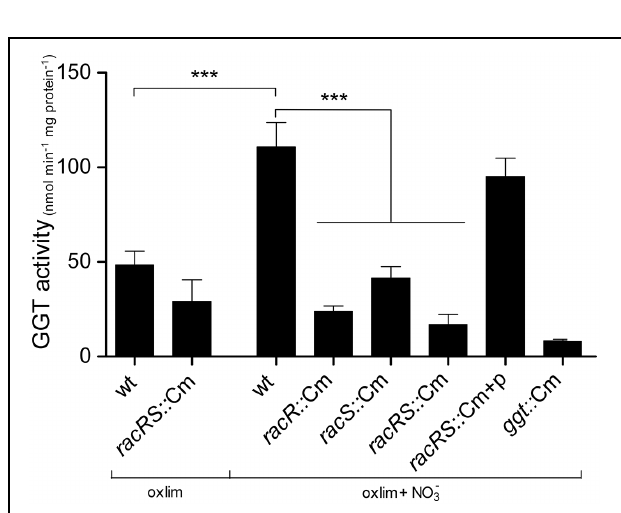
FIGURE 1 | RacR activates ggt transcription. Real-time RT-PCR data showing the transcript fold difference of the aspA, gltB, and ggt mRNA in the Campylobacter jejuni racR mutant ( racR ::Cm) and complemented strain ( racR ::Cm + p) compared to the wt. Cultures were grown in Heart Infusion broth (HI) medium with addition of nitrate until end-log phase under oxygen limiting conditions. Fold increase is calculated using the 2 (cid:3)(cid:3) Ct method using rpoD as reference gene. Data represent the mean values and SE of three independent experiments. ∗ p < 0.05, ∗∗∗ p < 0.001.